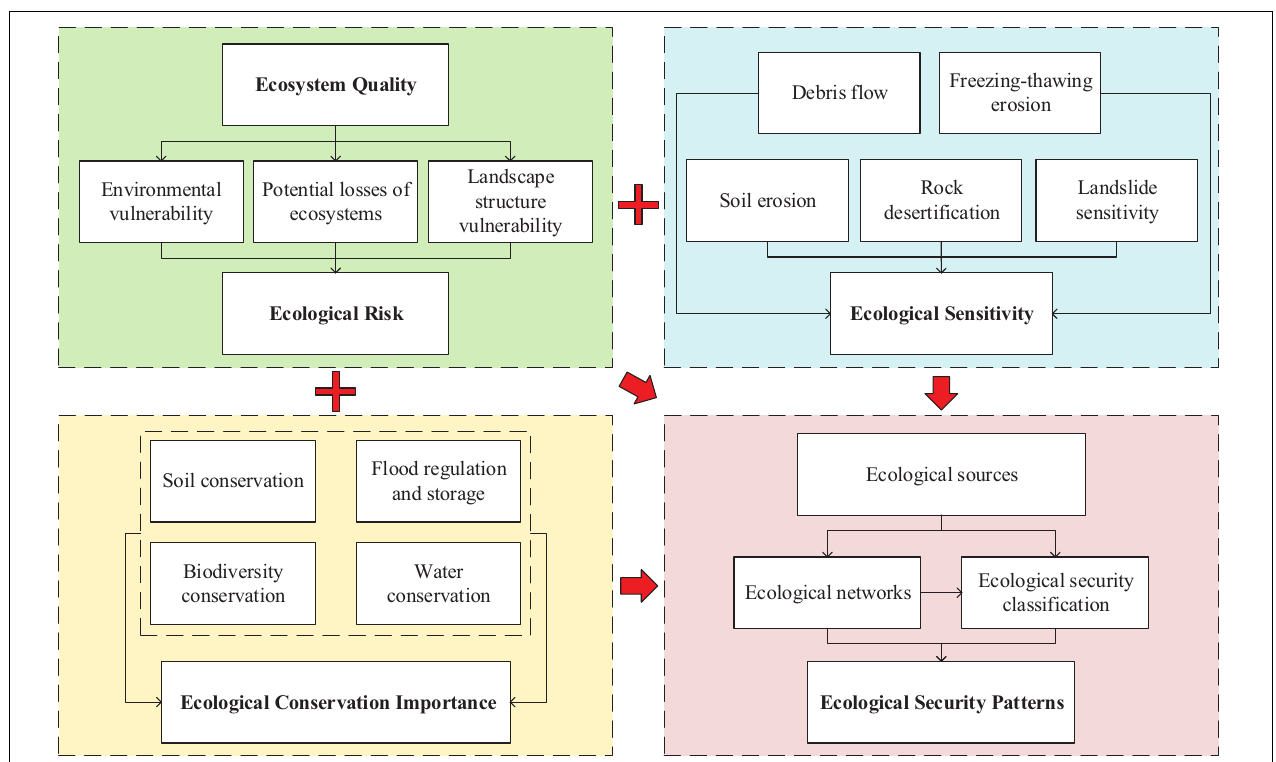
FIGURE 2 | Framework for identifying ecological security patterns based on ecosystem